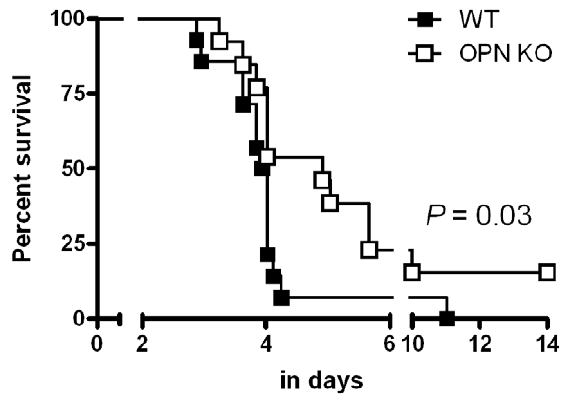
Figure 6. OPN KO mice show delayed mortality. Percentage survival of WT (closed symbols) and OPN KO (open symbols) mice after intranasal infection with 10 3 CFU of B. pseudomallei . n=14 per group. P value indicates the difference between